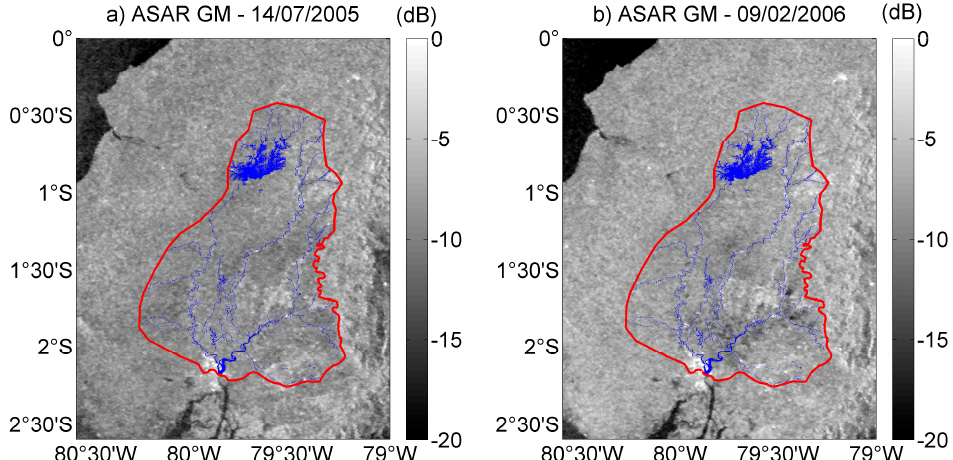
Figure 4. Images of backscattering obtained after the pre-processing of ENVISAT ASAR images in GM mode acquired during the ( a ) dry (14 July 2005); and ( b ) rainy (9 February 2006) seasons in the Guayas Basin lowland. The boundary of the lowland is represented using a red line and open water appears in blue.